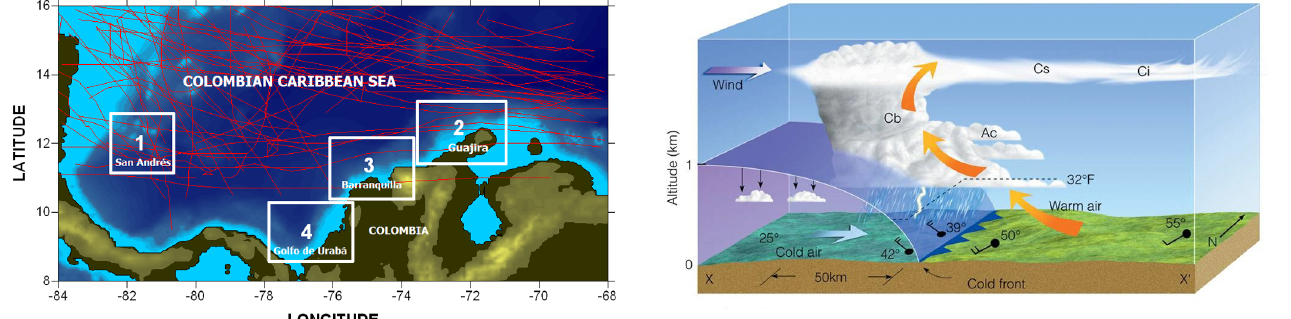
Fig. 1. Vulnerability of the Colombian Caribbean coast due to hur- ricanes (Ortiz, 2012).